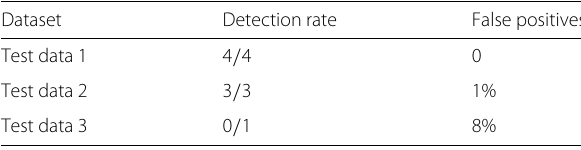
Table 10 Results of intrusion detection